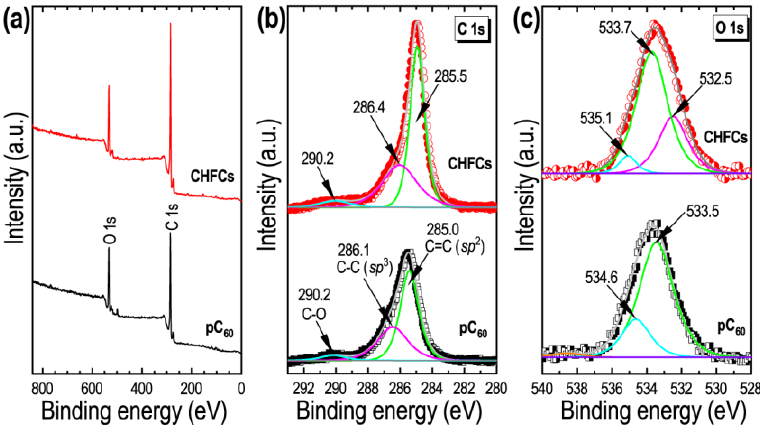
Figure 4. XPS studies of CHFCs and pC 60 : ( a ) XPS survey spectra; ( b ) C 1s spectra with the deconvoluted peaks; ( c ) O 1s spectra with the deconvoluted peaks.